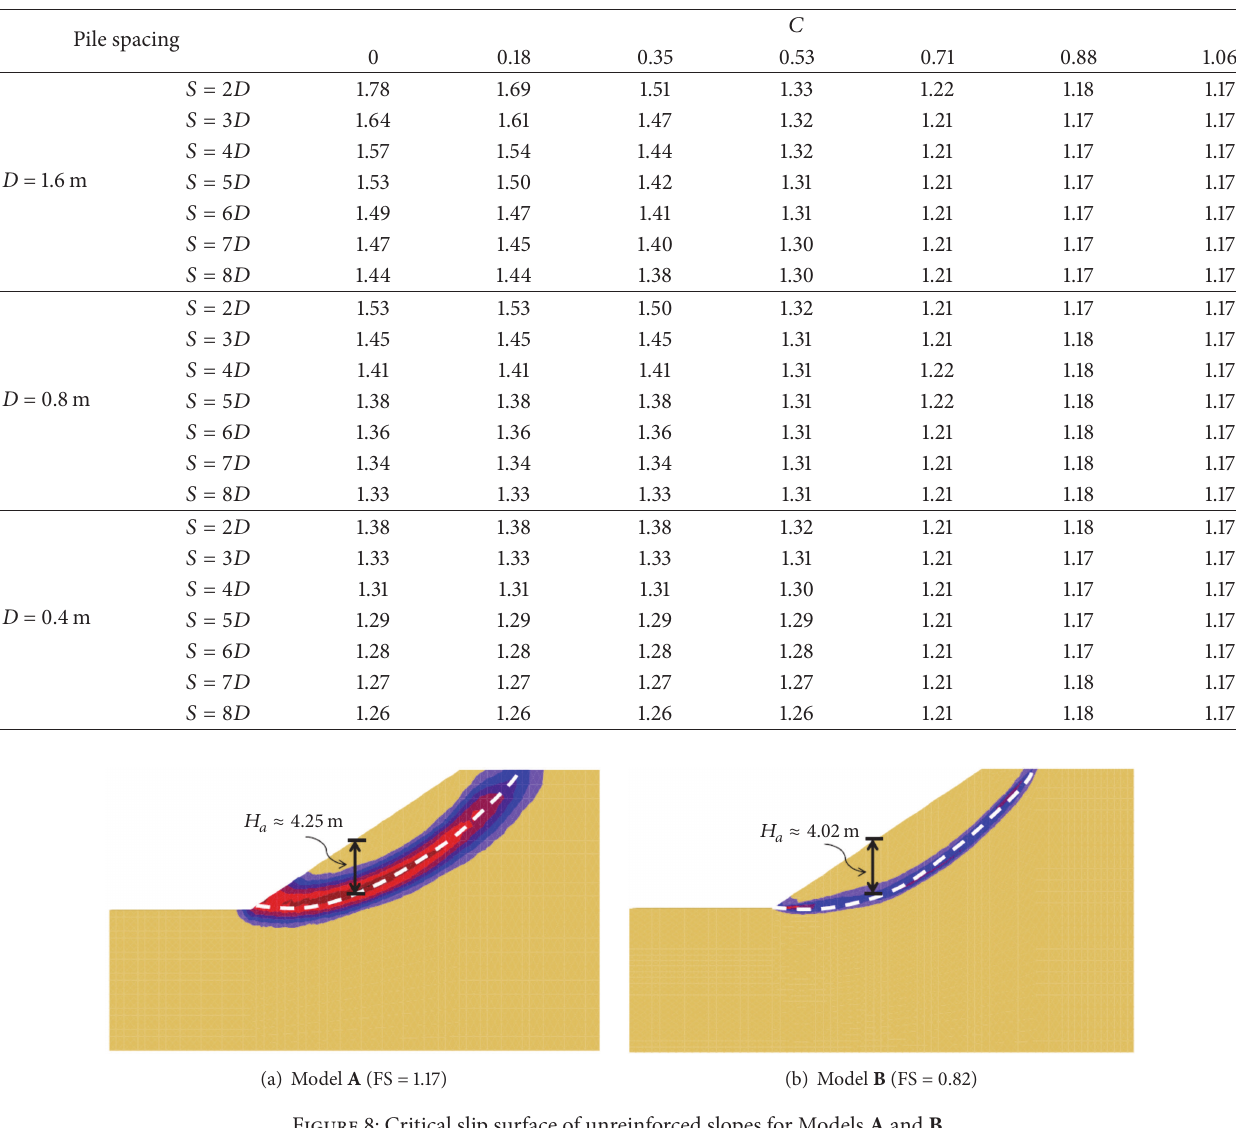
Table 2: FS values of piled slopes for Model A .